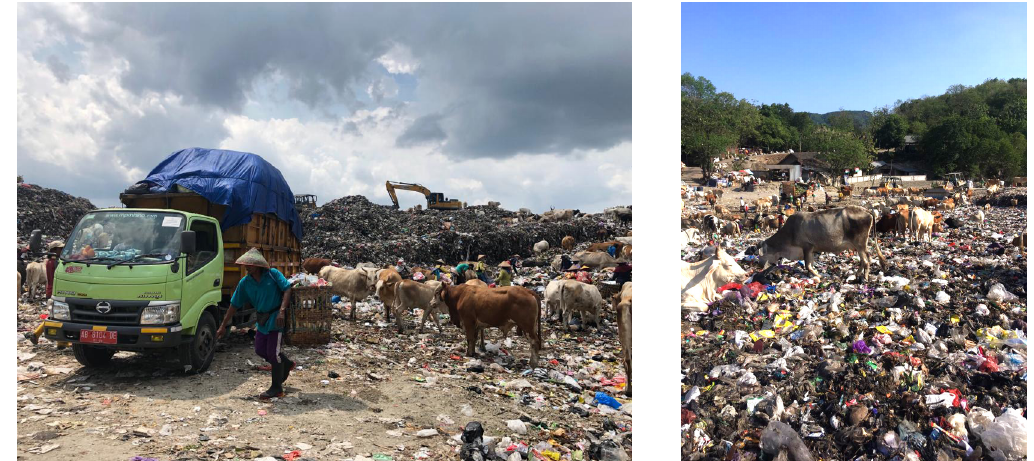
Figure 3. Cows herding and scavengers in Piyungan